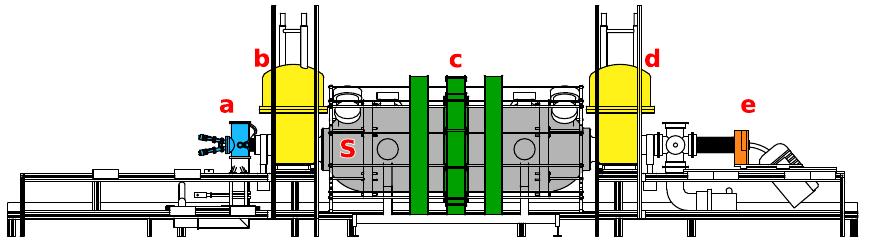
d ) and four air coils ( c ) to adjust the magnetic field at the center. The electrons are detectedby a LN 2 -cooled PIN diode ( e ). A full description of the system is found in